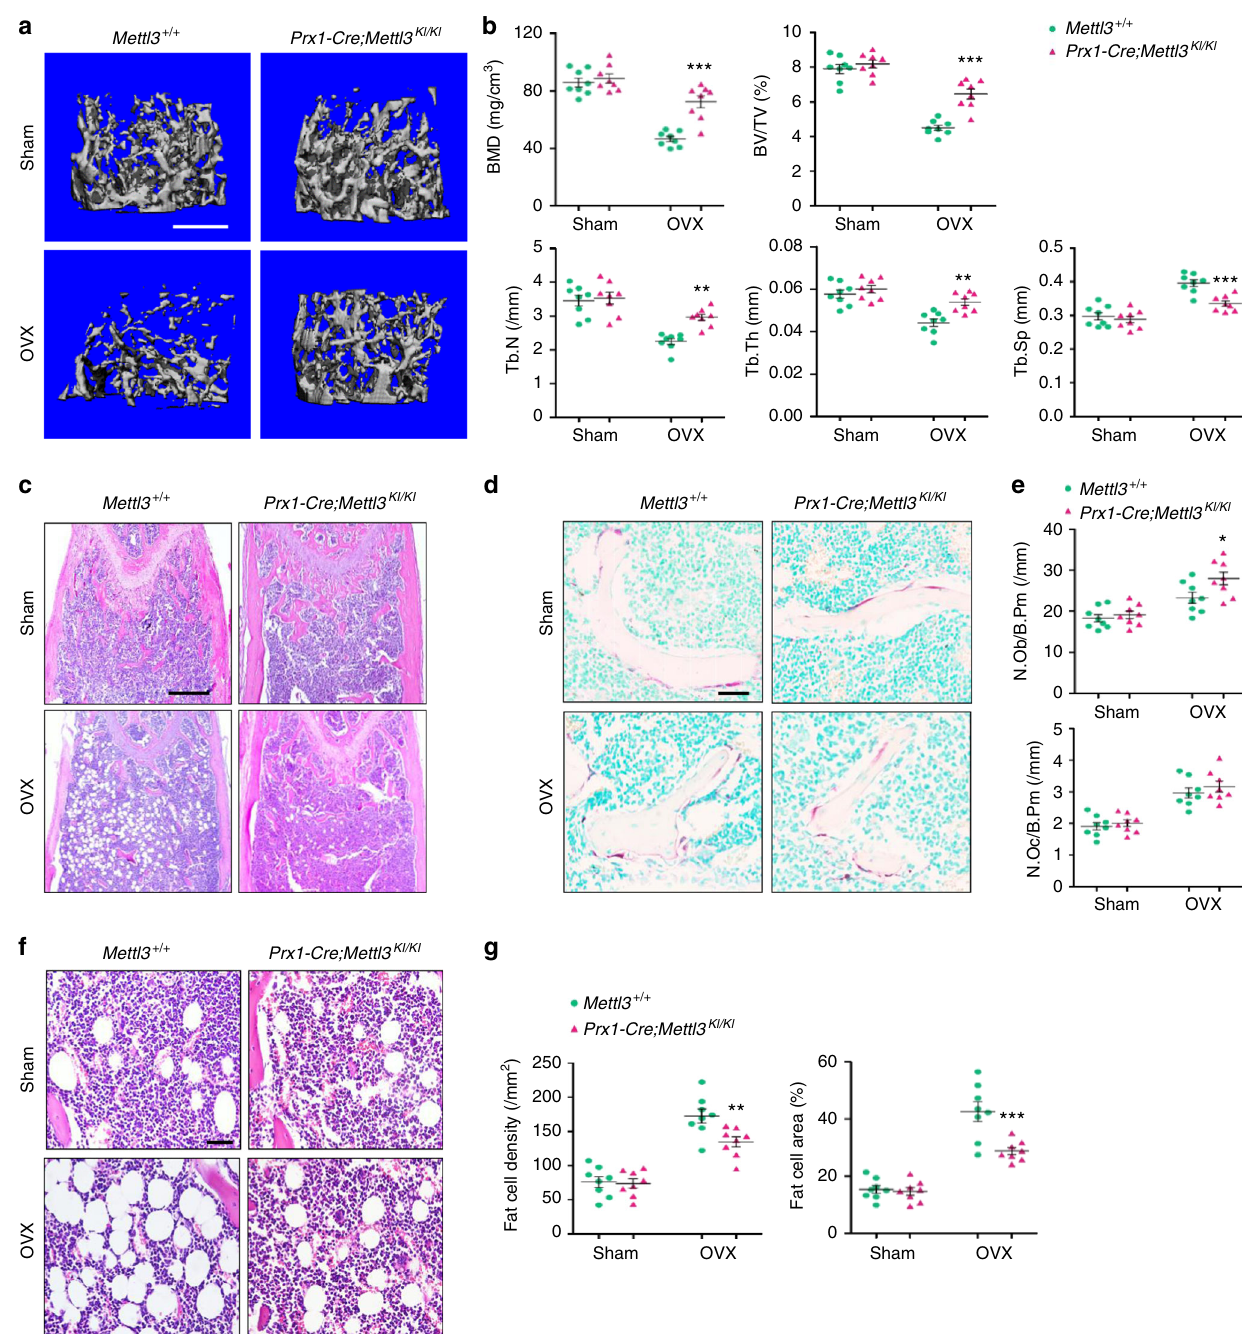
Fig. 4 Overexpression of Mettl3 in MSCs prevents estrogen de fi ciency-induced osteoporosis. a Representative images of μ CT reconstruction of distal femurs. Scale bar, 500 μ m. b Quantitative μ CT analyses of metaphysis region of distal femurs ( n = 8). c H&E staining of femoral sections from Mettl3 + l + and Prx1-Cre;Mettl3 KI/KI female mice following sham and OVX. Scale bar, 500 μ m. d TRAP staining of femur sections. Scale bar, 50 μ m. e Histomorphometric analyses of distal femurs following sham and OVX ( n = 8). f Representative H&E staining of femur sections exhibiting the marrow adipose tissue. Scale bar, 50 μ m. g Number and area of adipocytes in the distal marrow per tissue area ( n = 8). Data are expressed as mean ± s.e. m.; * P < 0.05, ** P < 0.01, *** P < 0.001 by two-way ANOVA with Bonferroni post tests the protein synthesis of Pth1r and further blocking the down- expression can lead to MAT accumulation as a consequence of stream signaling pathways of Pth1r responsive to PTH treatment. preferential adipogenic differentiation 34,35,50 . Mettl3 knockout reduced the global methylation level of m 6 A in mice and sig- Intermittent PTH treatment promotes bone formation, which ni fi cantly impaired Pth1r function. The persistence in high is achieved by increasing osteoblasts number, delaying osteoblast marrow adiposity and the poorly elevated bone mass in m 6 A apoptosis, activating bone-lining cells and reducing marrow de fi cient mice following intermittent PTH(1-34) injection sup- fat 34,42,44 . PTH1R is a direct signaling mediator of PTH in pro- ported a blunt response to PTH anabolic effect. Our subsequent moting osteoblastic lineage of MSCs while aberrant PTH1R NATURE COMMUNICATIONS| (2018) 9:4772 |DOI: